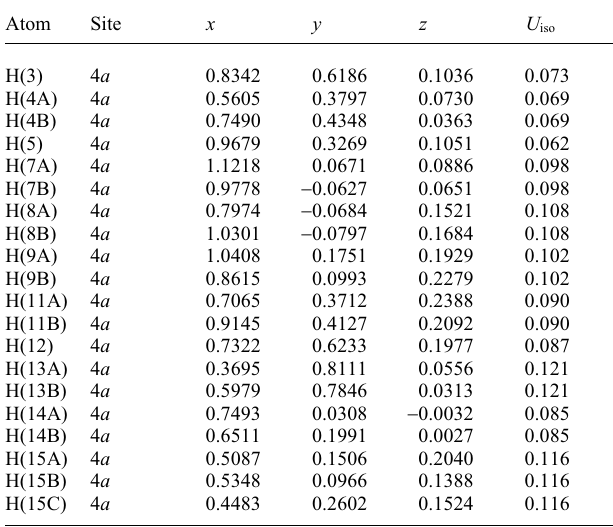
Inularacemosa isoneoftraditionalChinesedrugswhichhadvar- iousbiologicalandpharmaceuticalactivitiessuchanti-inflamma- tory, hepatoprotective activity, antidematophytic and antifungal activity [1, 2]. The roots of Inular racemosain our study were col- lected in Tibet. The title compound had been isolated from the ex- tracts of roots of Inula racemosa. Although (3a R ,8a S ,9a S )-8a- methyl-3,5-dimethylene-decahydronaphtho[2,3- b ]furan-2(3 H )- one was not a new compund, its X-ray crystal structure has not been reported in the literature [3]. This structure determination is part of our interest on the development of heterocyclic com- pounds [4, 5]. Table 2. Atomic coordinates and displacement parameters (in Å 2 ) . Atom